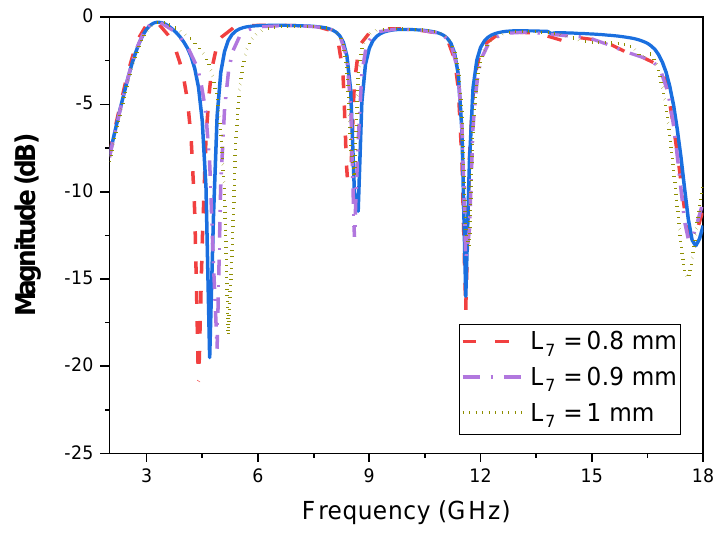
Figure 13. Validation of first band control w.r.t .